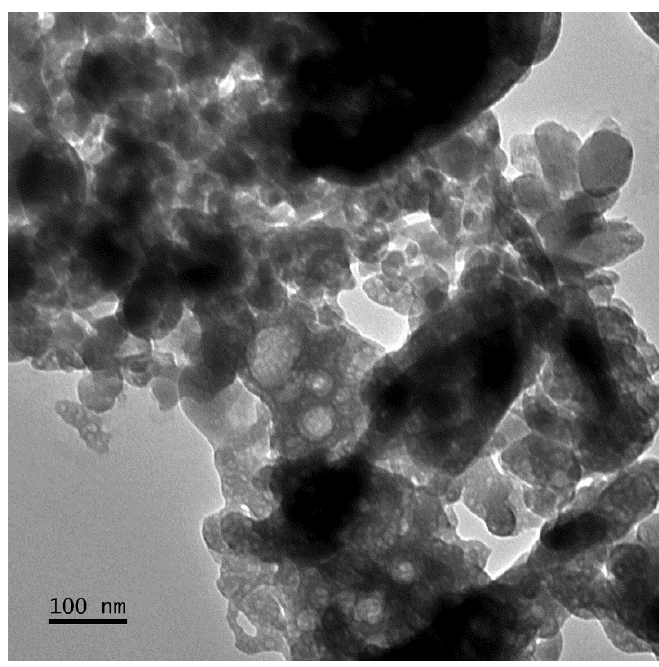
Figure 7. TEM analysis of Fe/Cu bimetallic nanoparticles.